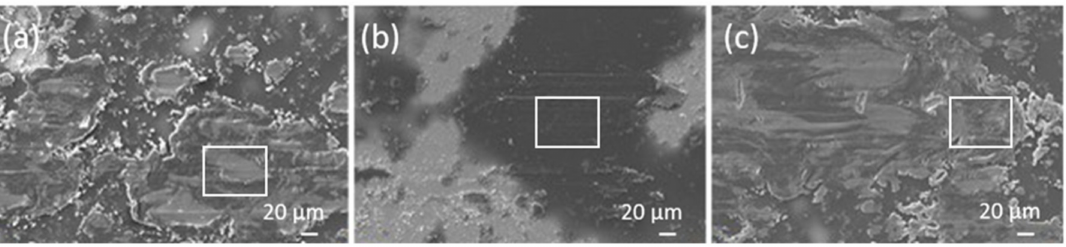
Figure 4. Wear tracks for TiO 2 coating; ( a ) dry sliding, ( b ) sliding in water and ( c ) sliding in Hank’s solution. Squares mark the energy-dispersive X-ray spectrometer (EDS) measurement sites.